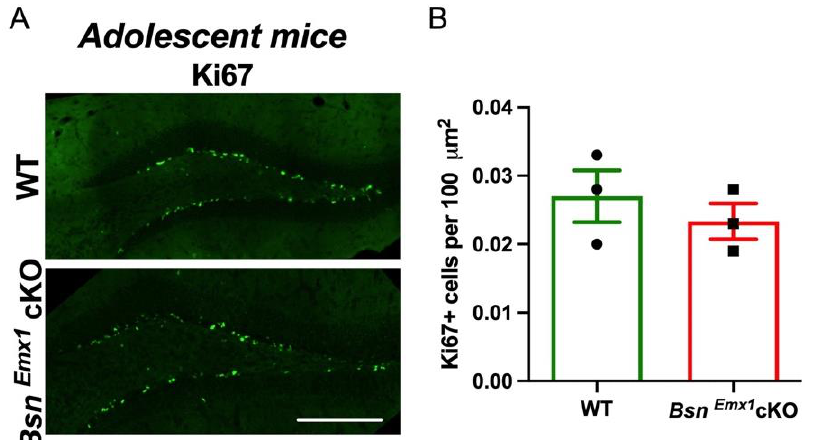
Figure 5 . Neurogenesis is not altered in adolescent (~4 – 5 weeks-old) Bsn Emx1 cKO mice. ( A ) Repre- sentative hippocampus sections from WT (N = 3 mice, n = 3 – 4 sections per animal) and Bsn Emx1 cKO (N = 3 mice, n = 4 sections per animal) showing cells positive for proliferation marker Ki67 (Ki67+) in the DG. Scale bar is 250 µm. ( B ) Quantification of Ki67+ cells in the suprapyramidal blade of